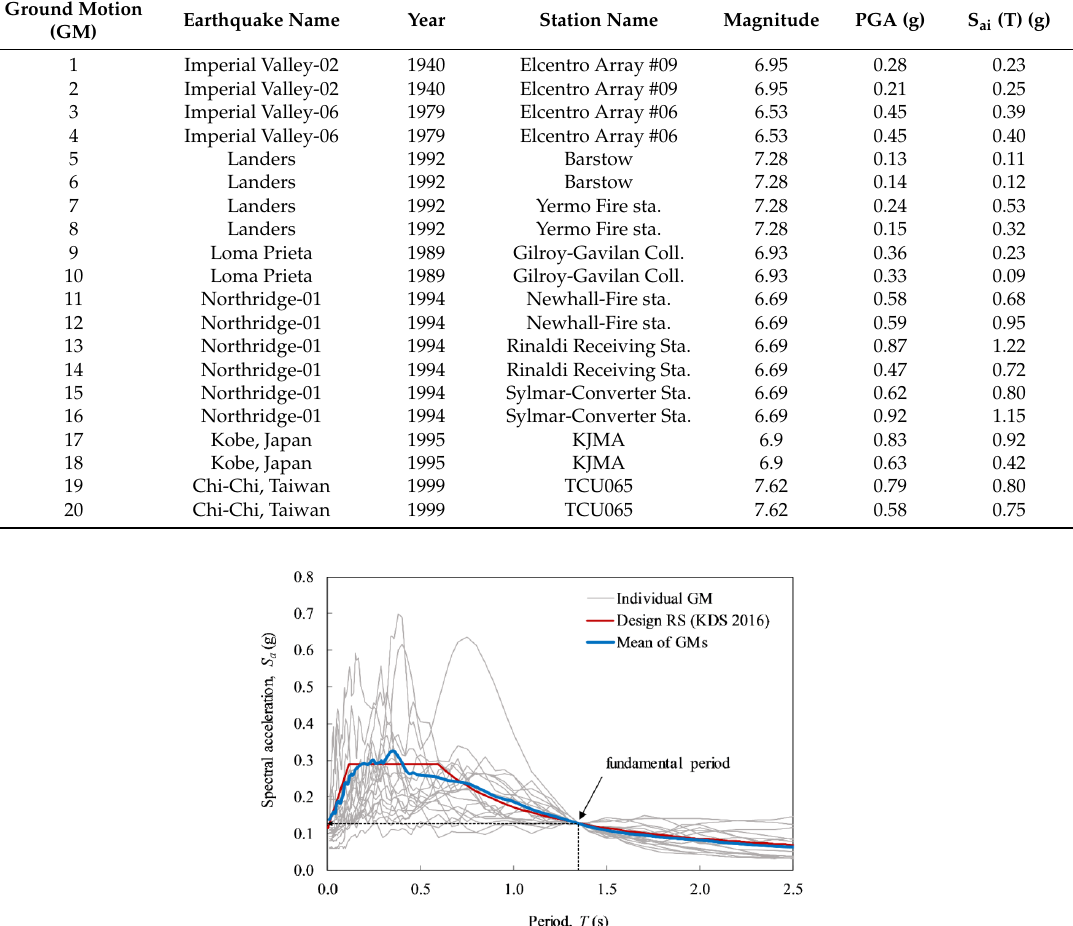
Table 4. Unscaled time-history accelerations.